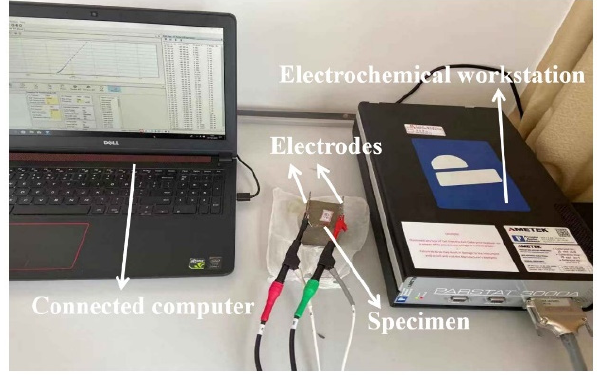
Figure 3. The measurement of AC electrical